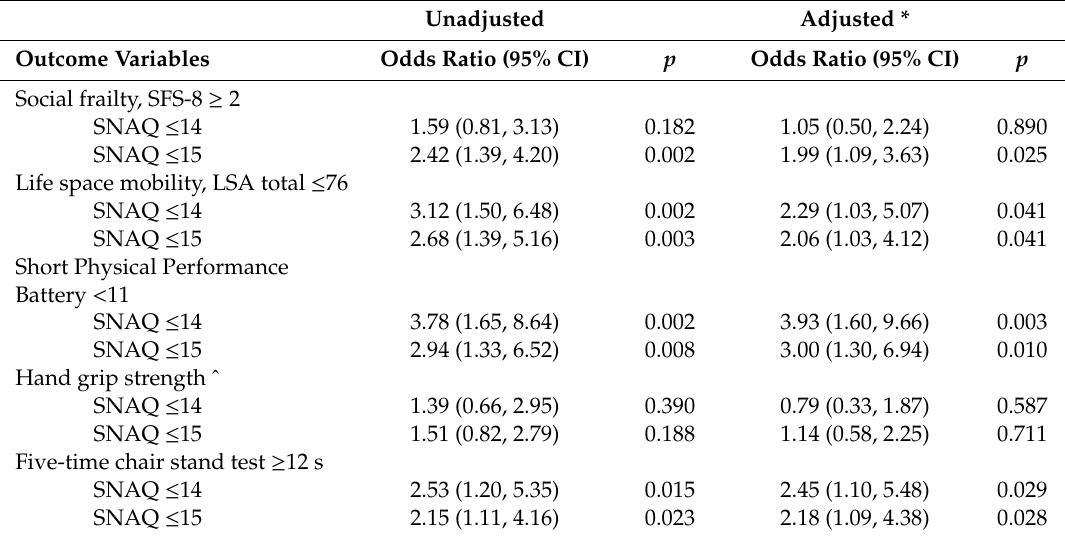
Table 6. Logistic Regression Models for Outcomes: Comparison between SNAQ ≤ 14 vs. SNAQ ≤ 15. Unadjusted Adjusted